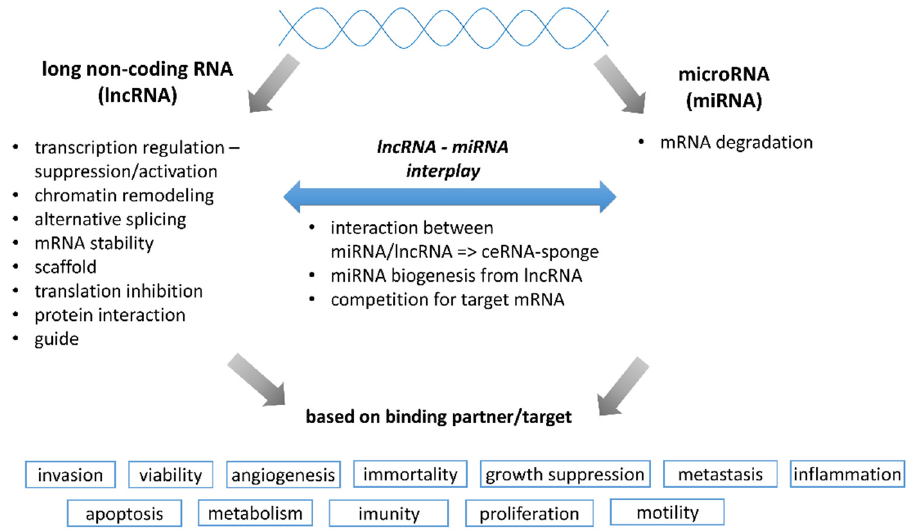
Figure 1. Simplified overview of lncRNA and miRNA functional properties. This figure shows possible interacting molecular determinants for lncRNA and miRNA as well as a wide range of cellular processes influenced by lncRNA/miRNA interactions with target binding partners.